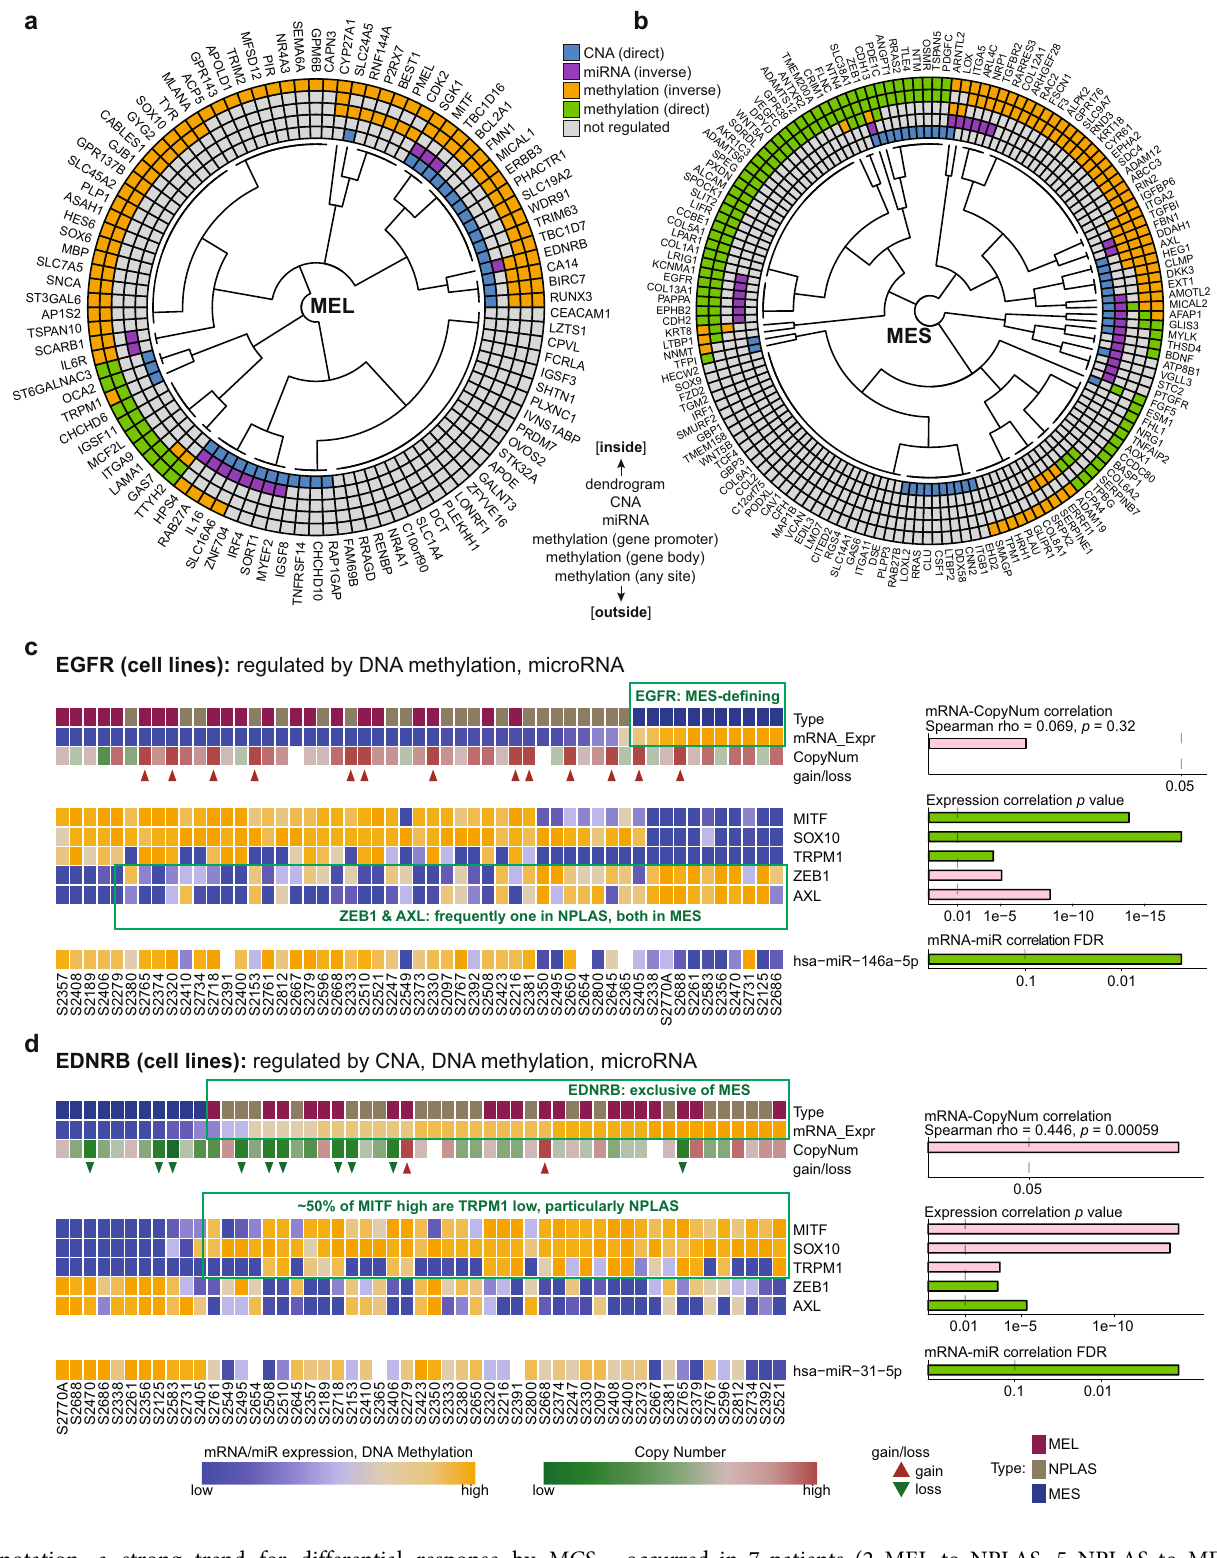
occurred in 7 patients (2 MEL to NPLAS, 5 NPLAS to MES), comprised of 3 non-responders and 4 responders ( p = 0.069, Fisher ’ s exact test; Fig. 7d). These data require further corroboration using a larger cohort, but suggest that regardless of the starting MCS, patients who display a shift in MCS towards a more MES phenotype during PD-1 CPI treatment, may have a higher likelihood of response to this therapy.